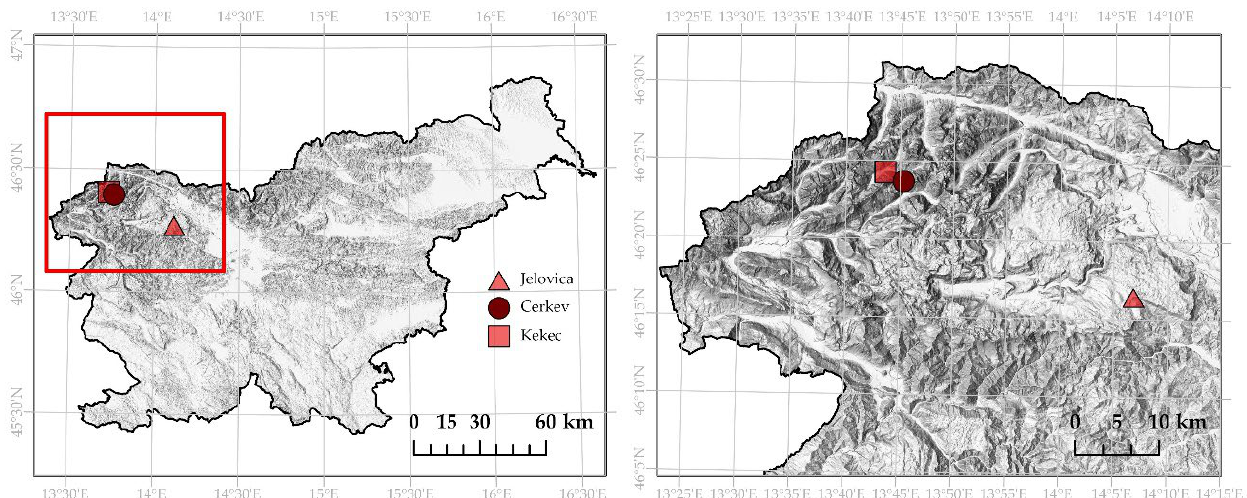
Figure 1. The locations of study sites.